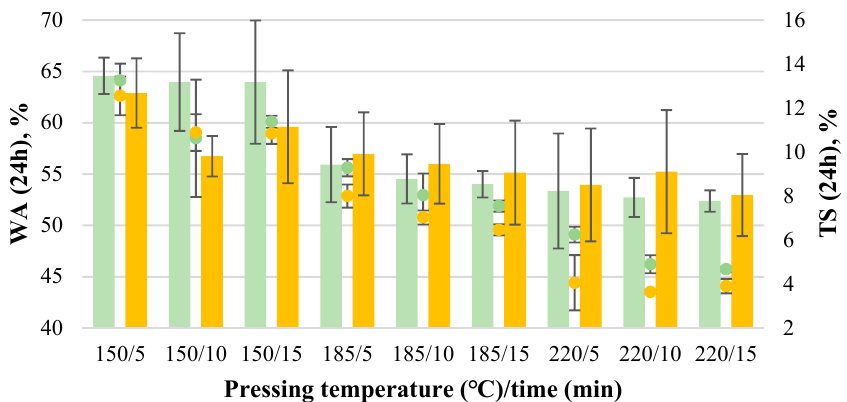
Figure 4. WA and TS of binder-less boards with a density of 800 kg m − 3 depending on the crop and pressing variables.